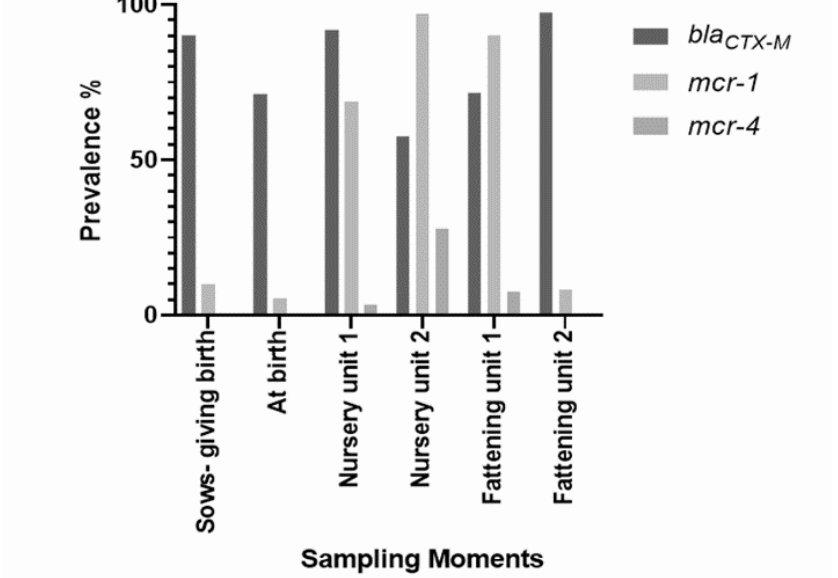
Figure 1. Prevalence of bla CTX-M and mcr -producing E. coli throughout the piglets’ life. The first sampling moment refers to the sows, when they give birth ( n = 10). The following five sampling moments refer to the piglets from farrow-to-finish. At each sampling moment, E. coli isolates were selected by phenotypic features on cefotaxime supplemented MacConkey agar, and their identity was confirmed by gadA PCR, which led to obtaining f a different number of isolates over the time of the study.